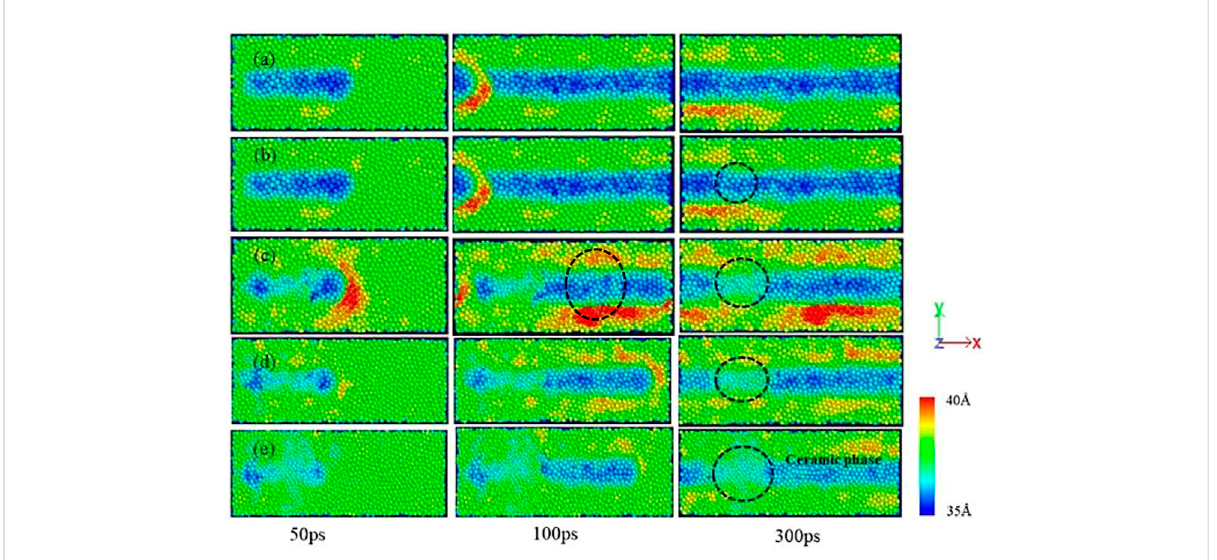
FIGURE 6 Atomistic representations of different Al 2 O 3 content models: (A) pure Fe-based amorphous model; (B) 5 wt% Al 2 O 3 /Fe amorphous composite model; (C) 10 wt% Al 2 O 3 /Fe amorphous composite model; (D) 10 wt% Al 2 O 3 /Fe amorphous composite model; (E) 20 wt% Al 2 O 3 /Fe amorphous composite